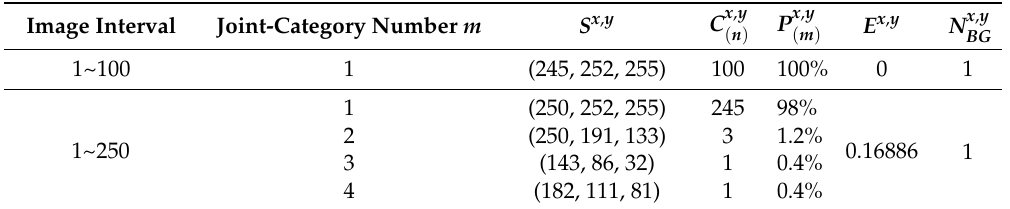
Table 2. Color classification results of the first to 250th input images at the coordinate (72, 38). Image